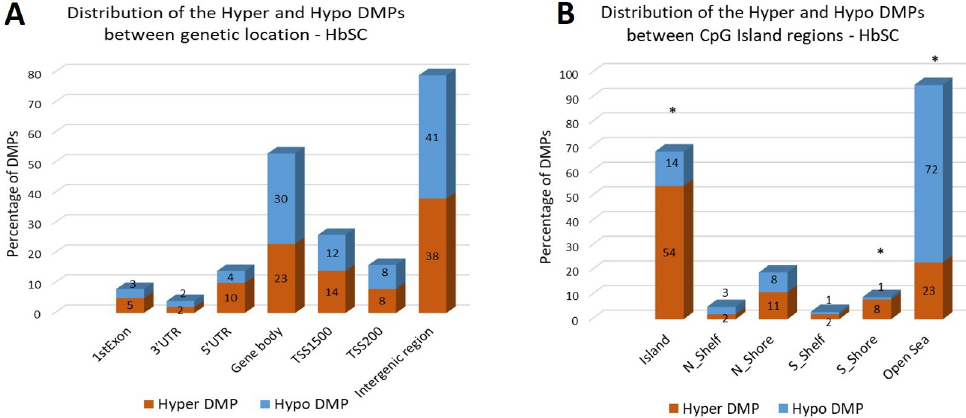
Fig 5. ( A ) The distribution of hyper DMPs and hypo DMPs according to their distance from the promoter. TSS1500 , 200 to 1500 base pairs upstream of the transcription start site (TSS); TSS200 , 200 base pairs upstream of the TSS; 5 0 UTR , 5 0 untranslated region; 1st Exon ; 3 0 UTR , 3 0 untranslated region. (B) The distribution of hyper DMPs and hypo DMPs in different genomic region types. Island , a CpG site located within a CpG island; Shore , a CpG site located < 2 kilobases from a CpG island (N_: located at North; S_: located at South); Shelf , a CpG site located > 2 kilobases from a CpG island; Open sea , a CpG site not in an island or annotated gene. Data of DMPs obtained from the comparison between HbSC vs Control groups. � : group of DMPs (hyper or hypomethylated) statistically more frequent in a specific region (p < 0.05; chi- square distribution